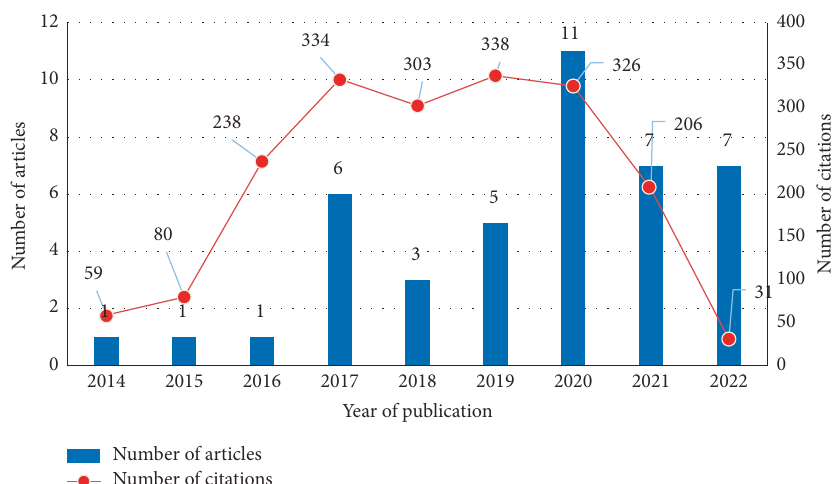
Figure 5: The number of articles and citations received based on the year of